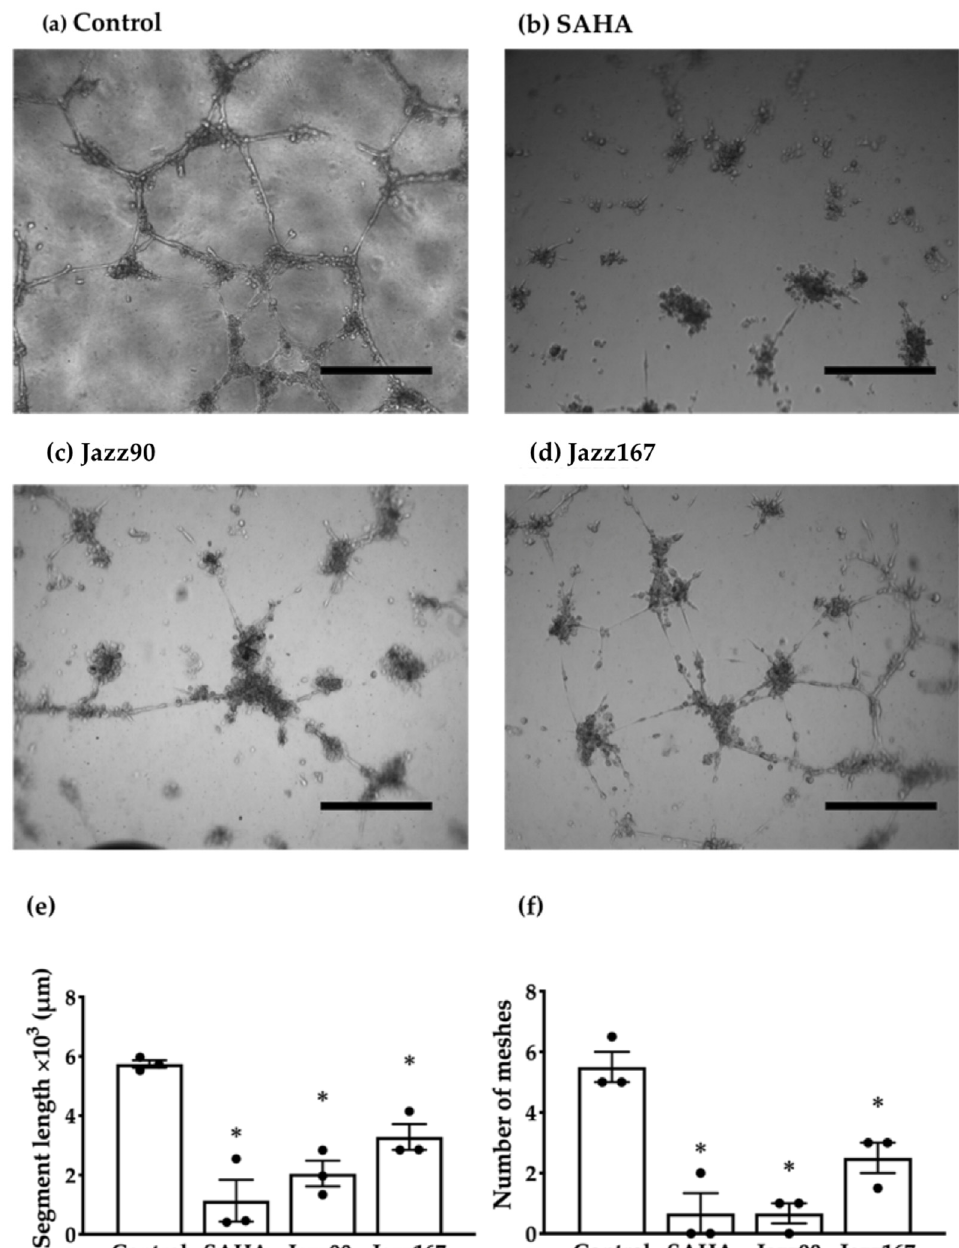
Figure 2. Tube formation in HUVEC cells following HDAC inhibitor treatment. HUVEC cells grown on Matrigel were treated with SAHA, Jazz90 and Jazz167 at a concentration of 4 µM. Control cells were treated with 0.5% DMSO. After 24 h, images were captured using a light microscope. Representative images from HUVEC cells treated with ( a ) control, ( b ) SAHA, ( c ) Jazz90 and ( d ) Jazz167 are shown. The black bars indicate 500 µm at a magnification of ×40. The Angiogenesis analyser plugin was used in ImageJ to quantify the ( e ) number of meshes and ( f ) segment lengths. Bars represent the mean ± S.E.M. from 3 independent experiments, as shown by the data points. Data were analysed using a one-way ANOVA coupled with a Bonferroni’s post-hoc test. *significantly decreased relative to the control, p < 0.05.